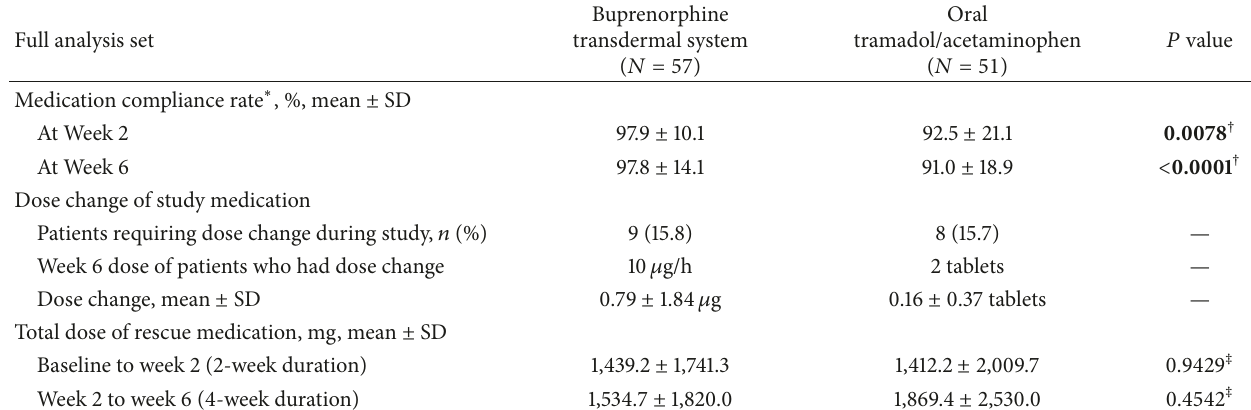
Table 4: Medication compliance rate, dose change, and use of rescue medication.